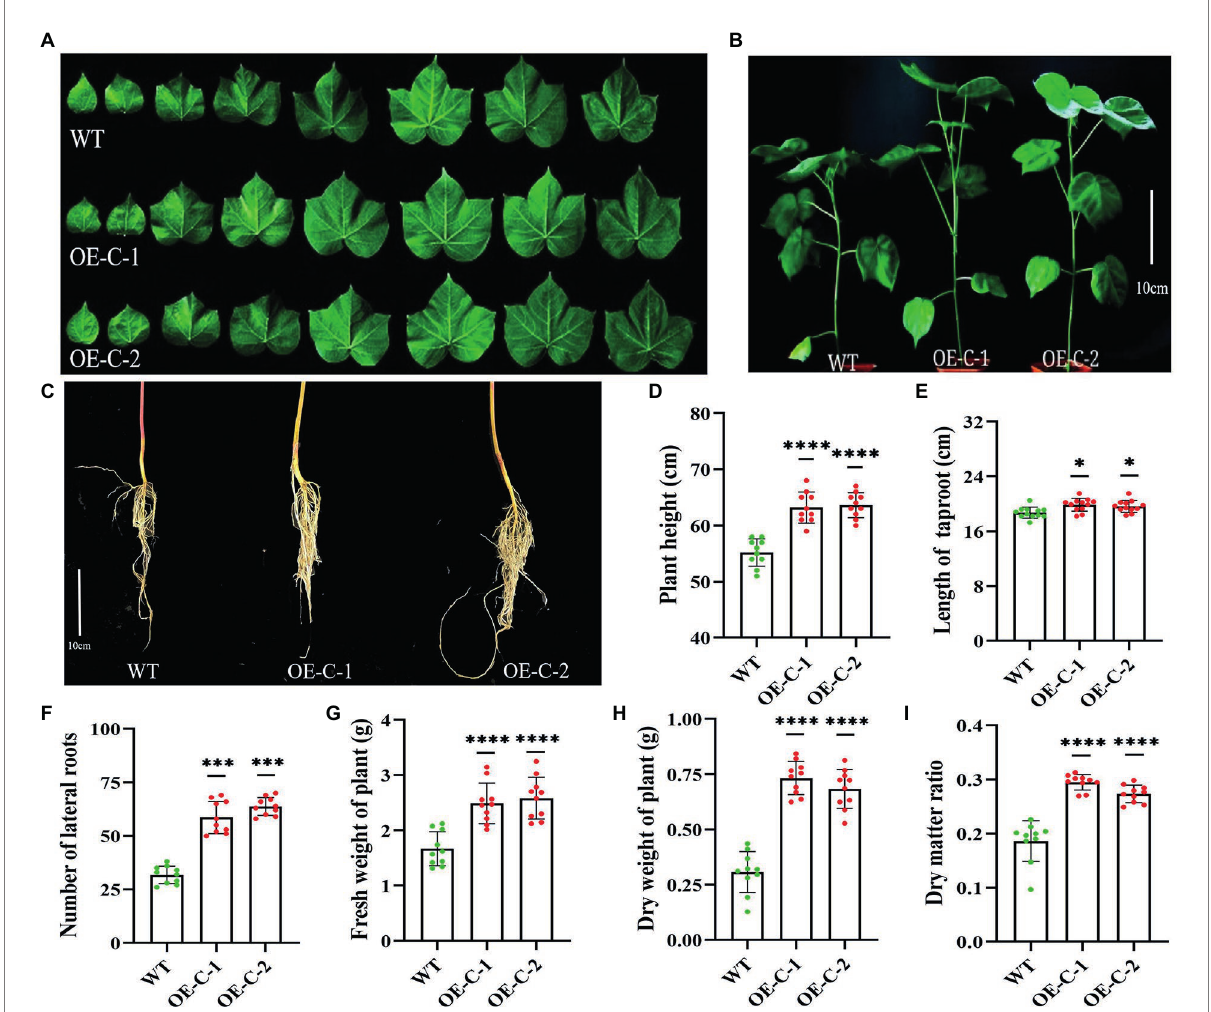
FIGURE 2 Growth analysis of DgCspC transgenic cotton lines. (A) Comparison of leaf size between transgenic and wild-type cotton lines; (B) growth phenotype of wild type and transgenic cotton lines; (C) root morphology between wild type and transgenic cotton lines; (D) height comparison between wild type and transgenic cotton lines; (E) length of taproot; (F) number of lateral roots; (G) fresh weight of plant; (H) dry weight of plant; (I) dry matter ratio. Asterisks indicate significant differences between WT and the OE-C-1/ OE-C-2 transgenic lines. (* p < 0.05, *** p < 0.001, **** p < 0.0001 for comparisons between the transgenic lines and wild-type plants by Student’s t